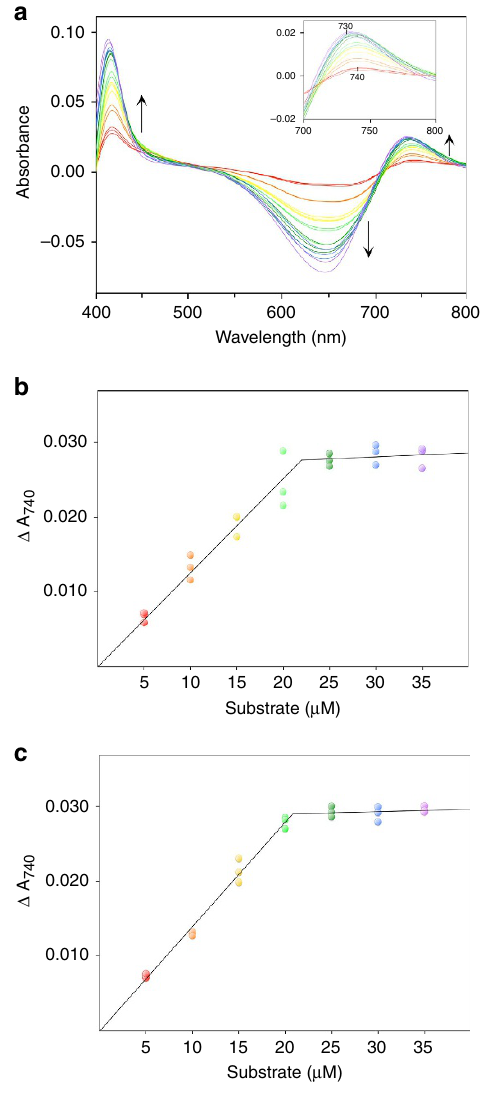
Figure 6 | Determination of the stoichiometry of BV binding to Syn BVR. ( a ) BV titration of Syn BVR (10 m M), as determined from the difference absorption spectra acquired in the presence of NADP þ . Arrows indicate trends of spectral changes. ( b ) Titration curve of Syn BVR observed at 740nm. ( c ) Titration curve of the Syn BVR R185A mutant. Measurements were performed in